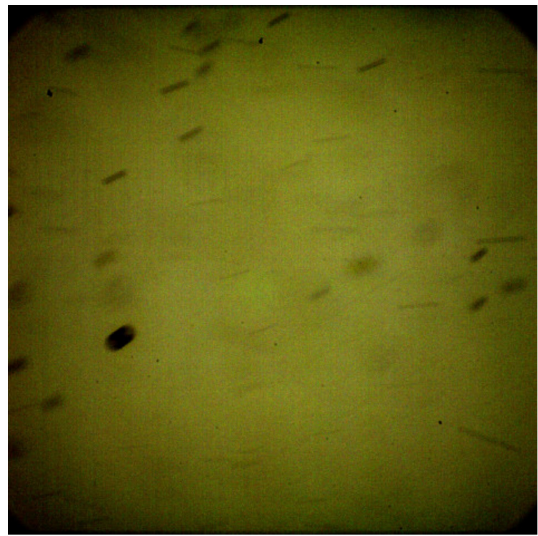
Figure 5. Microscopic images of the droplets.